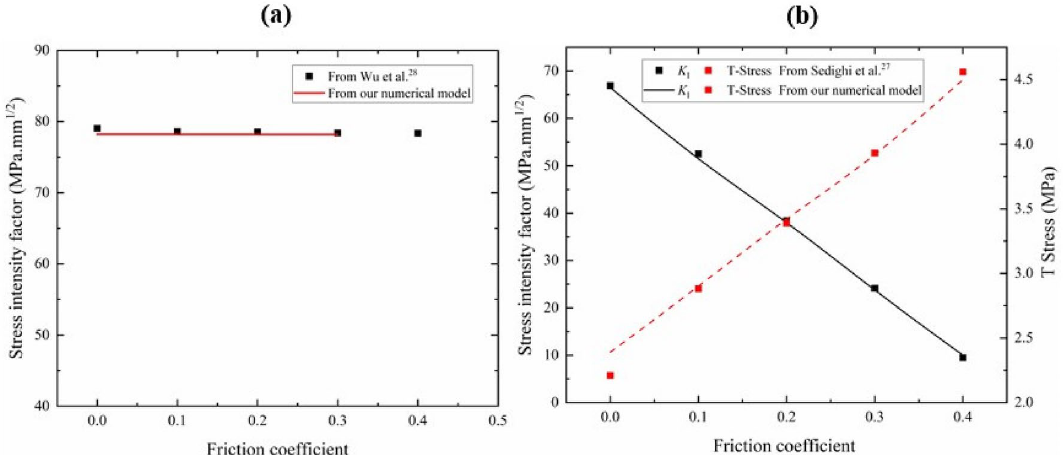
Figure 2. The trends for stress intensity factor of rock specimens with ( a ) CSTBD configuration and ( b ) NSCB configuration against the friction